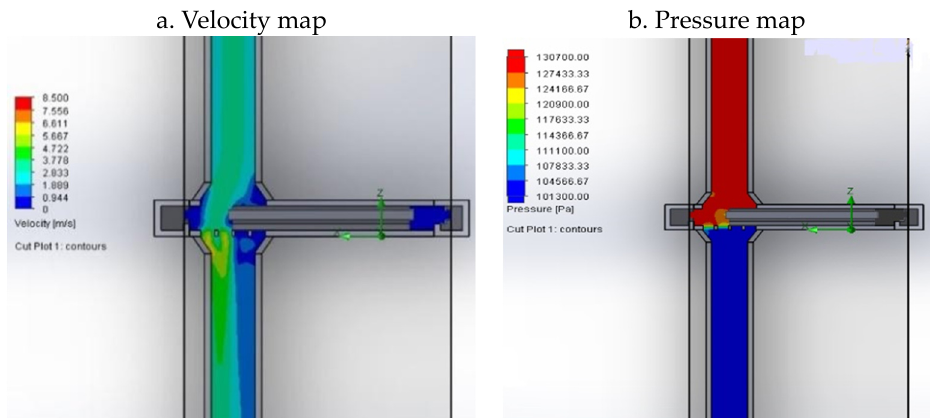
Figure 19. Third valve geometry with 50% opening.